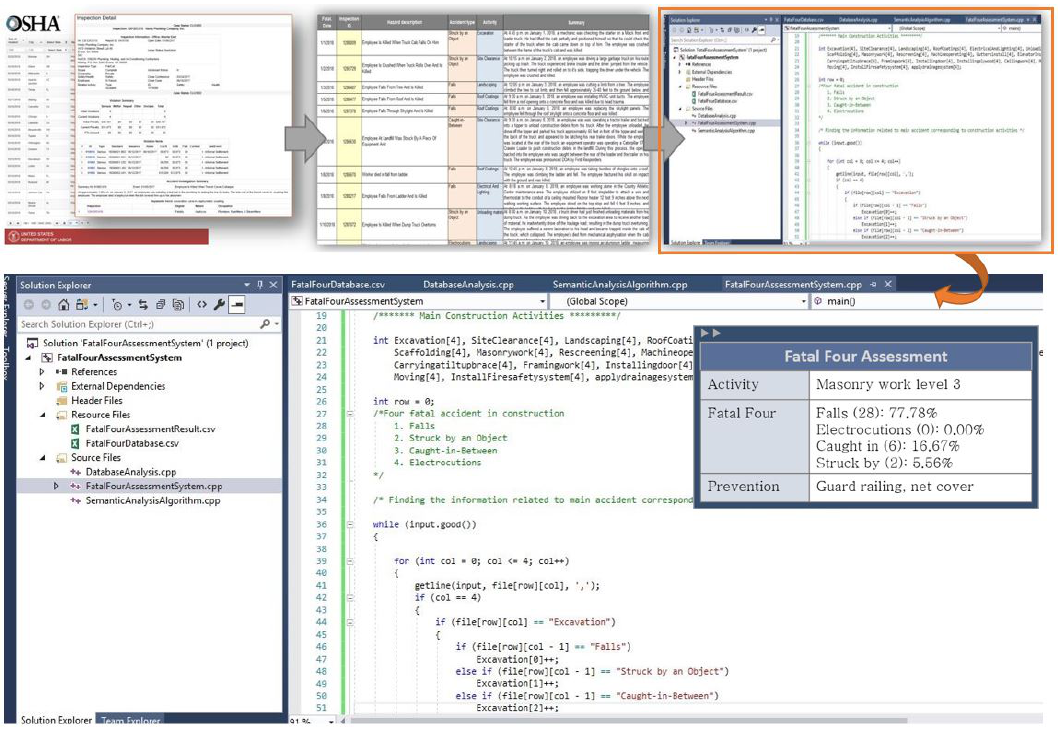
Figure 4. Fatal Four assessment